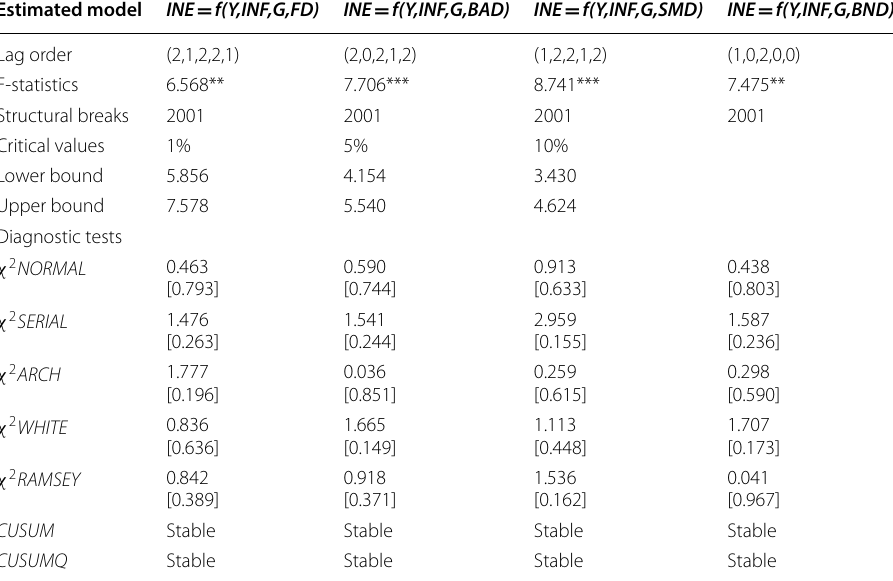
** and *** indicates statistical significance at 5 and 1% level, respectively. The numbers in brackets are p values. The critical values are obtained from Narayan (2005)